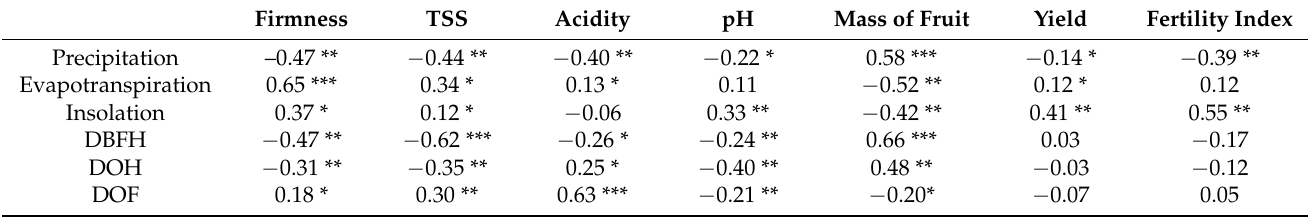
Table 12. Influence of weather condition on fruit quality